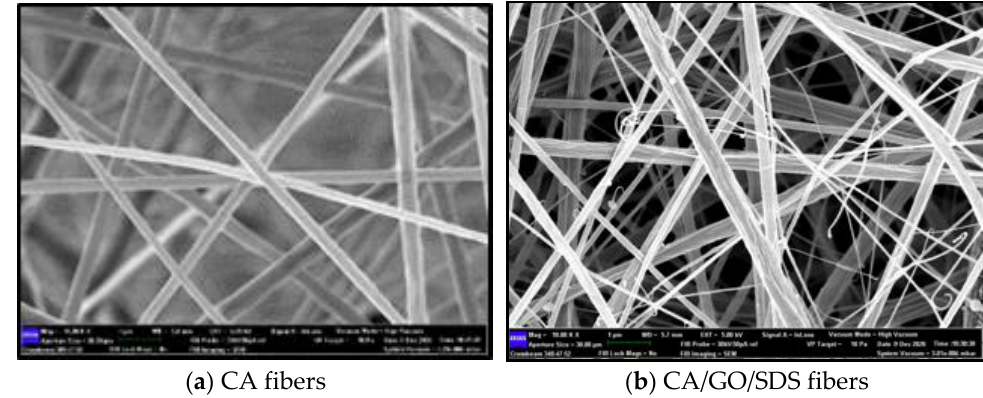
Figure 2. FESEM images for CA and